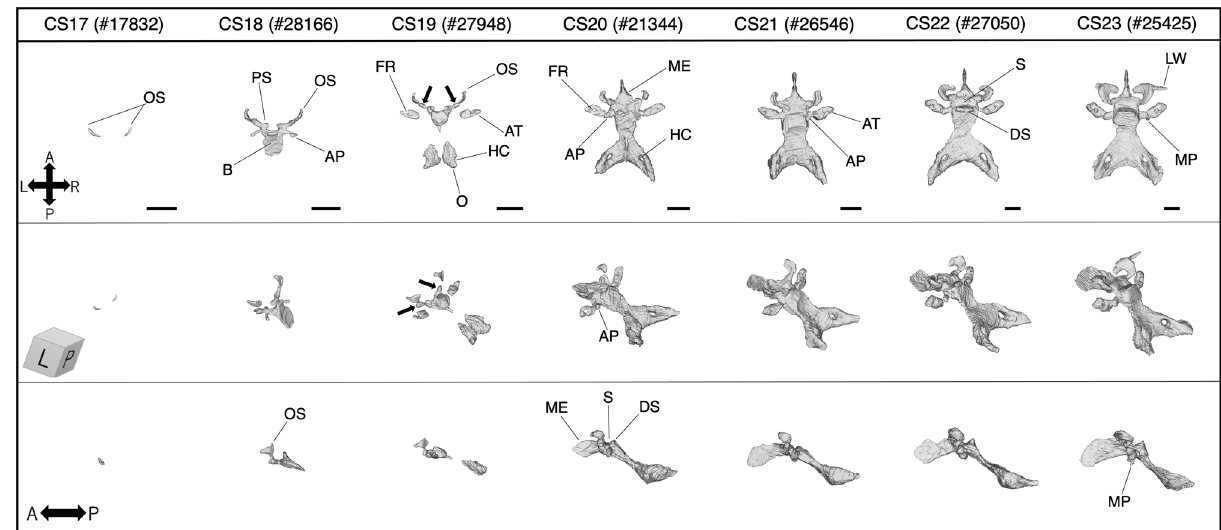
Figure 3. The 3D models reconstructed using PCX-CT. Typical appearance of the sphenoid (including the occipital and the nasal septum) in each stage (black bar: 1 mm). Note that these are not necessarily corresponding to the findings recorded in Table 2 and Fig. 2 which are the results of HS observation. Arrows (CS19) indicate a structure that articulates with the orbitosphenoid and presphenoid, which is called “postorbital root of the orbital wing” or “hypochiasmatic alae” in previous reports. HS, histological section; PCX-CT, phase- contrast CT; AT, ala temporalis; AP, alar process; B, basisphenoid; DS, dorsum sella; FR, foramen rotundum; HC, hypoglossal canal; LW, lateral part of the lesser wing; ME, mesethmoid; MP, medial pterygoid process; O, occipital; OS, orbitosphenoid; PS, presphenoid; S, sella tunica.